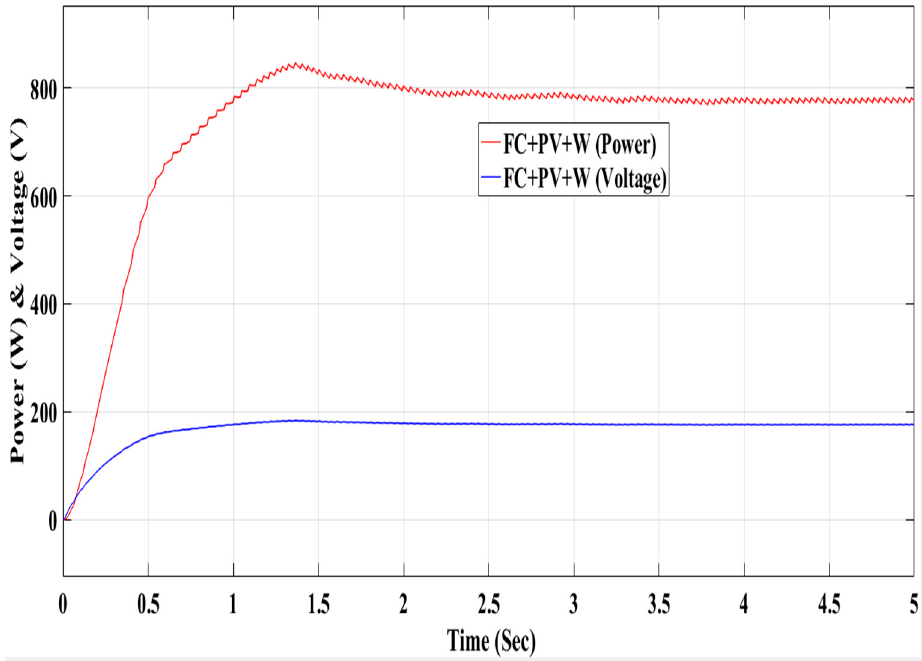
Figure 26. Power and voltage characteristics of the FC–PV–W model using the P&O-based MPPT method.